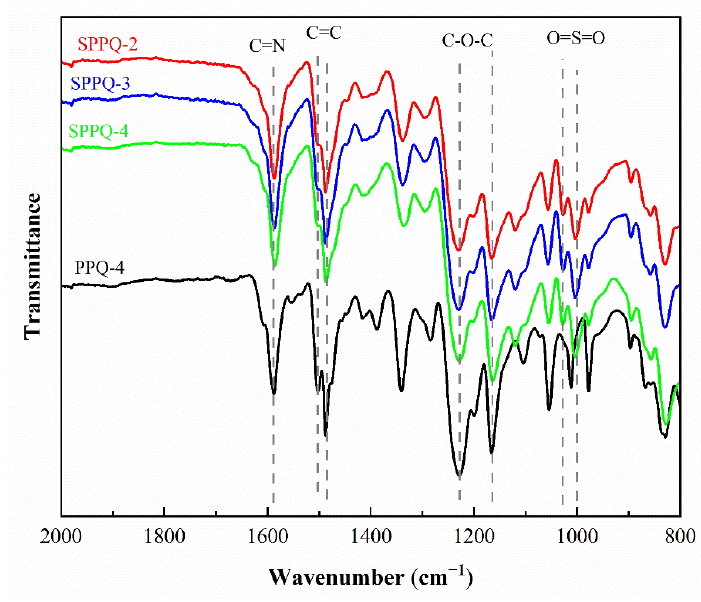
Figure 4. FTIR spectra of PPQ and SPPQs.